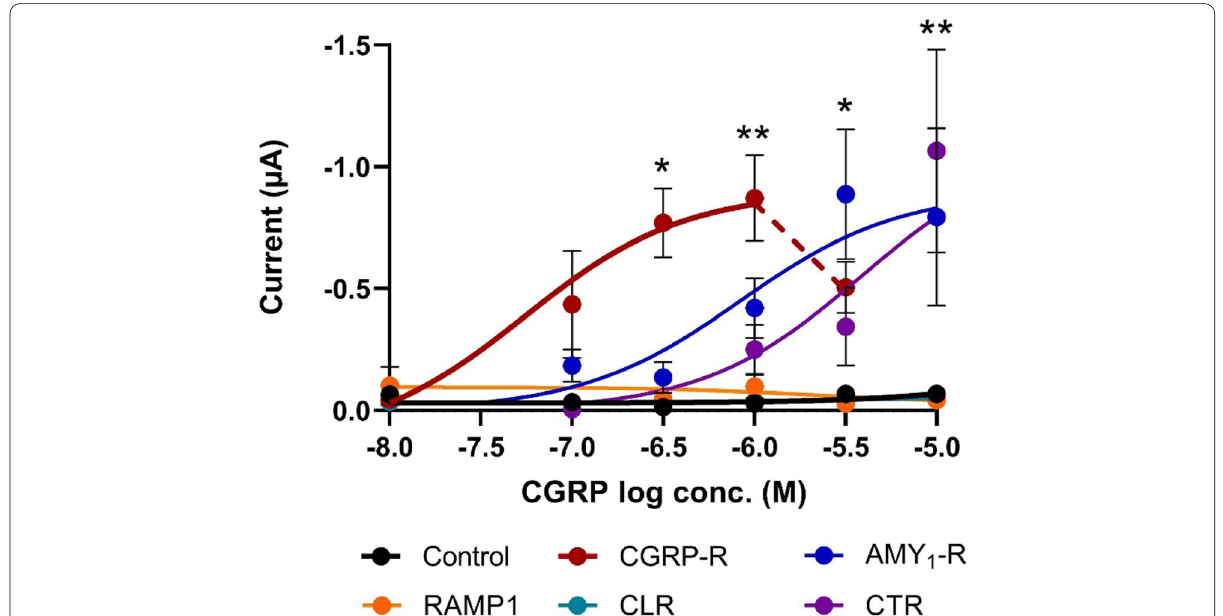
Fig. 3 Application of CGRP to Xenopus laevis oocytes expressing CGRP‑R, AMY 1 ‑R and CTR caused a concentration‑dependent increase in current at a holding potential of 70 mV with CGRP being most potent on CGRP‑R before the AMY 1 ‑R and CTR. CGRP had no effect on oocytes expressing − RAMP1, CLR or non‑injected oocytes (control). Curve fittings by non‑linear regression curves using least square non‑lin fit of the c‑r relationship of log(agonist) vs. response (three parameters) were performed. The top and the bottom of the curves were constrained to the maximum response of CGRP and zero, respectively for CGRP‑R, AMY 1 ‑R and CTR. Furthermore, the response to 3 μM of CGRP at the CGRP‑R was not included in the calculation of the non‑linear regression curve (indicated by dashed line) Statistical evaluation was performed by ordinary One‑way ANOVA followed by Dunnet’s multiple comparisons test on the response to the different concentrations of CGRP at each receptor as compared to the 1 μM CGRP response in non‑injected control oocytes * p < 0.05; ** p < 0.01. The number of experiments performed at each data point is between 2 and 15. Each curve‑fitting relies on experiments performed on 13 non‑injected oocytes, and 36, 30, 20, 14 and 27 oocytes expressing CGRP‑R, AMY 1 ‑R, RAMP1, CLR and CTR,